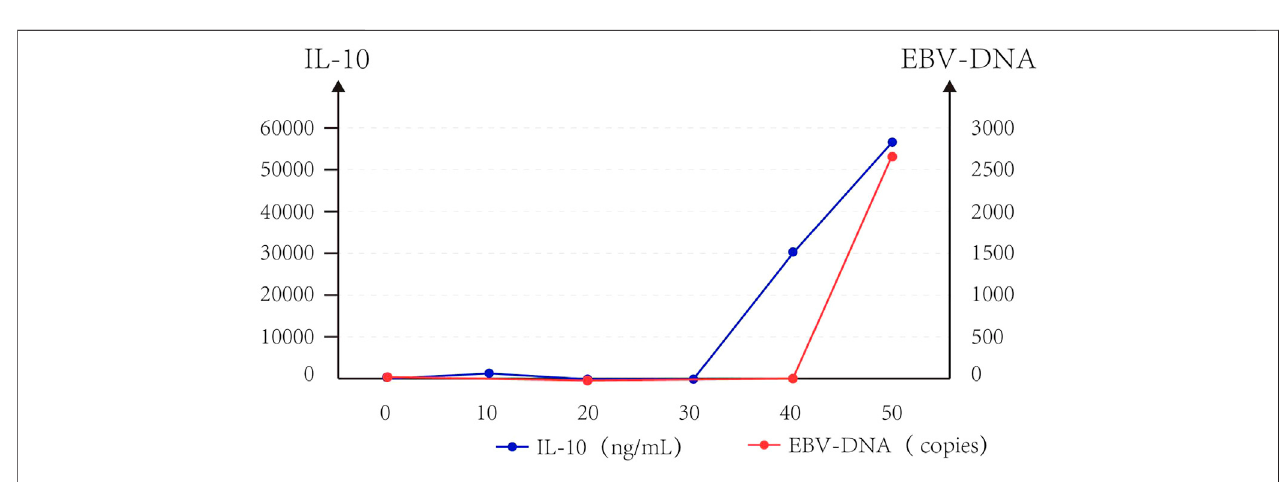
FIGURE 3 | Trend of other indirect monitoring